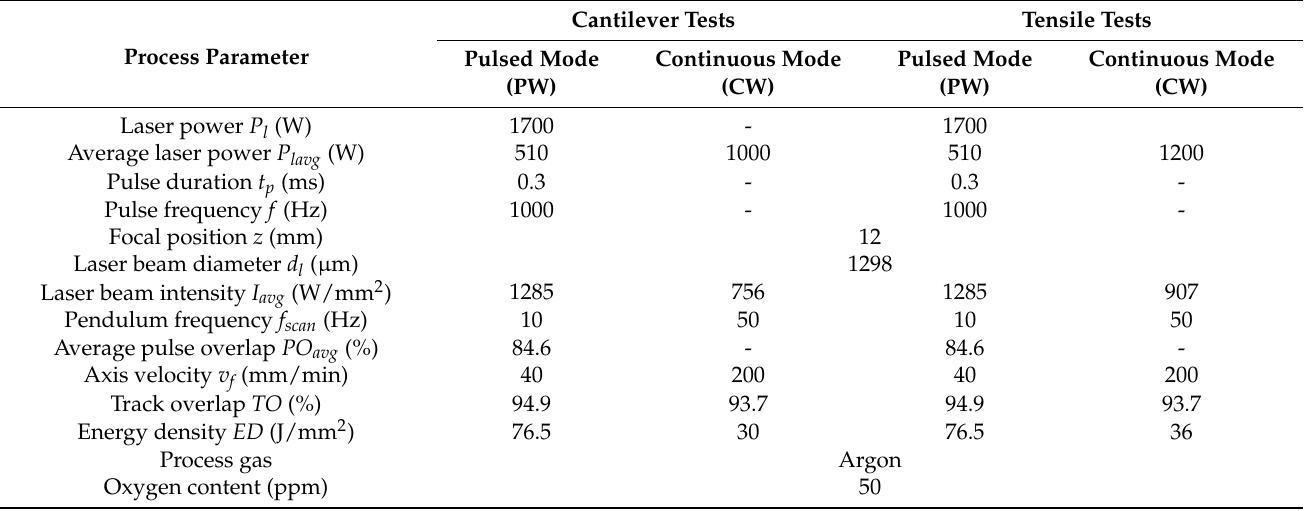
Table 3. Used process parameters at laser